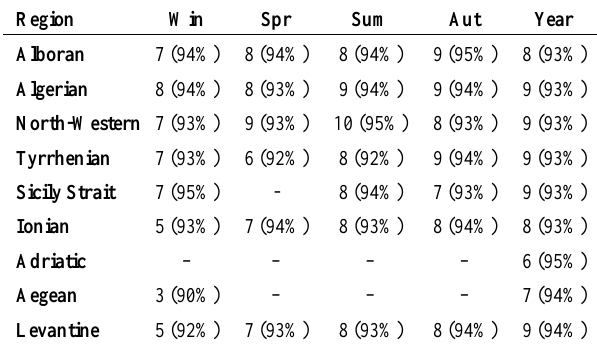
Table 6. The order of the optimum reduced set of EOFs as indicated by a value of the ratio of the root mean square residuals to the stan- dard deviations of 30%. The percentage of total variance explained is shown in parentheses